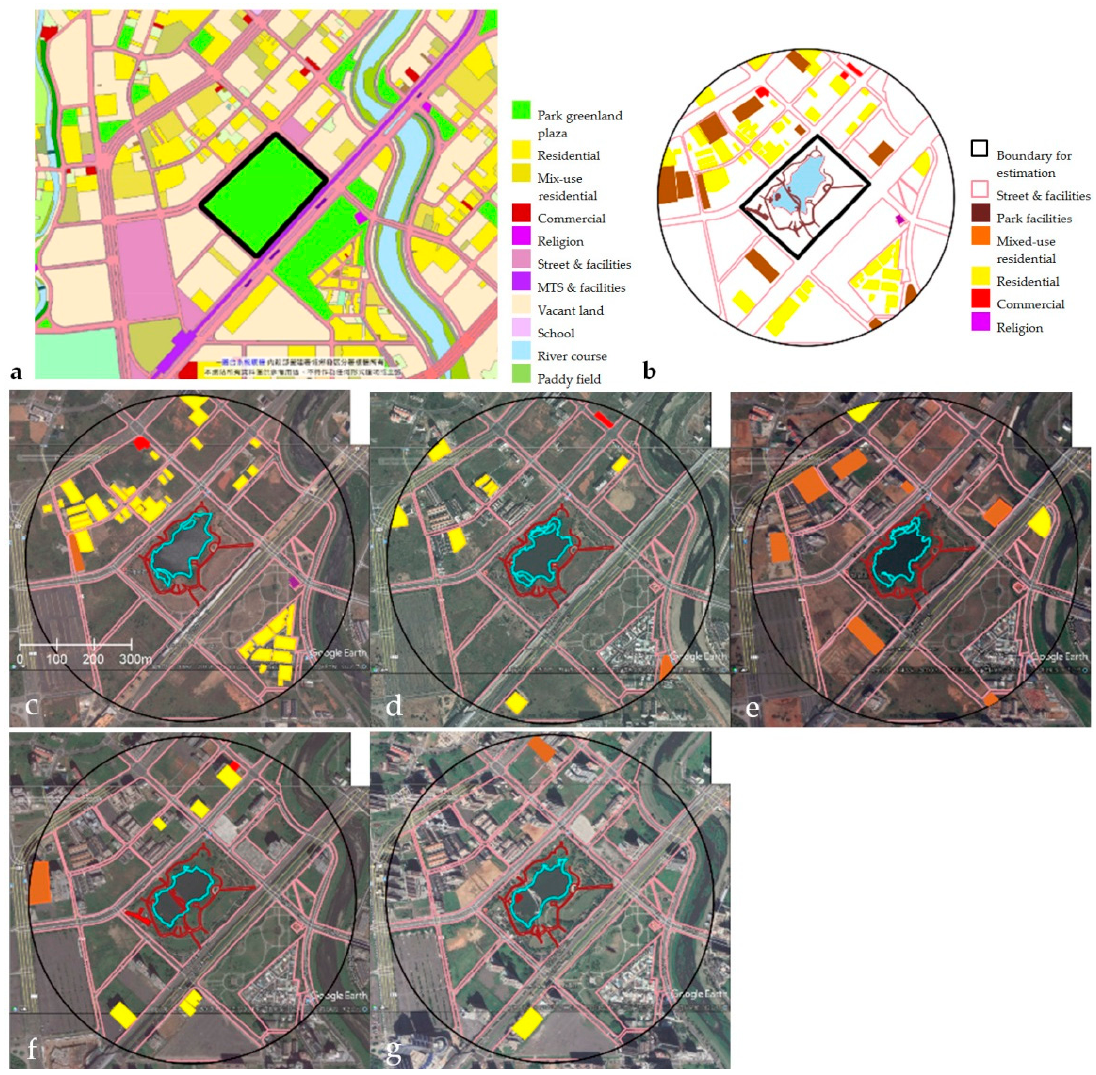
Figure 6. Land use districts in 2019 ( a ) and building types in 2020 ( b ); area of modifications is highlighted for ( c ) 2010, ( d ) 2012, ( e ) 2014, ( f ) 2016, and ( g ) 2018.